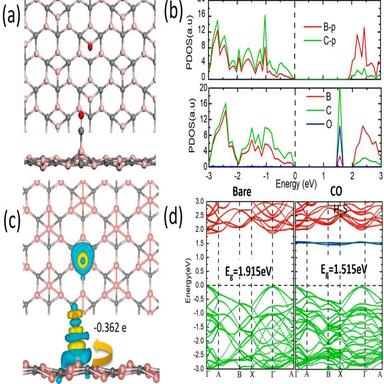
(a) Top and side views of the CO adsorbed electronic structure. (b) The density of state before and after adsorption. (c) The differential charge density of the CO/B4C3 configuration. (d) Band structure of pristine and CO-adsorbed B4C3, respectively.